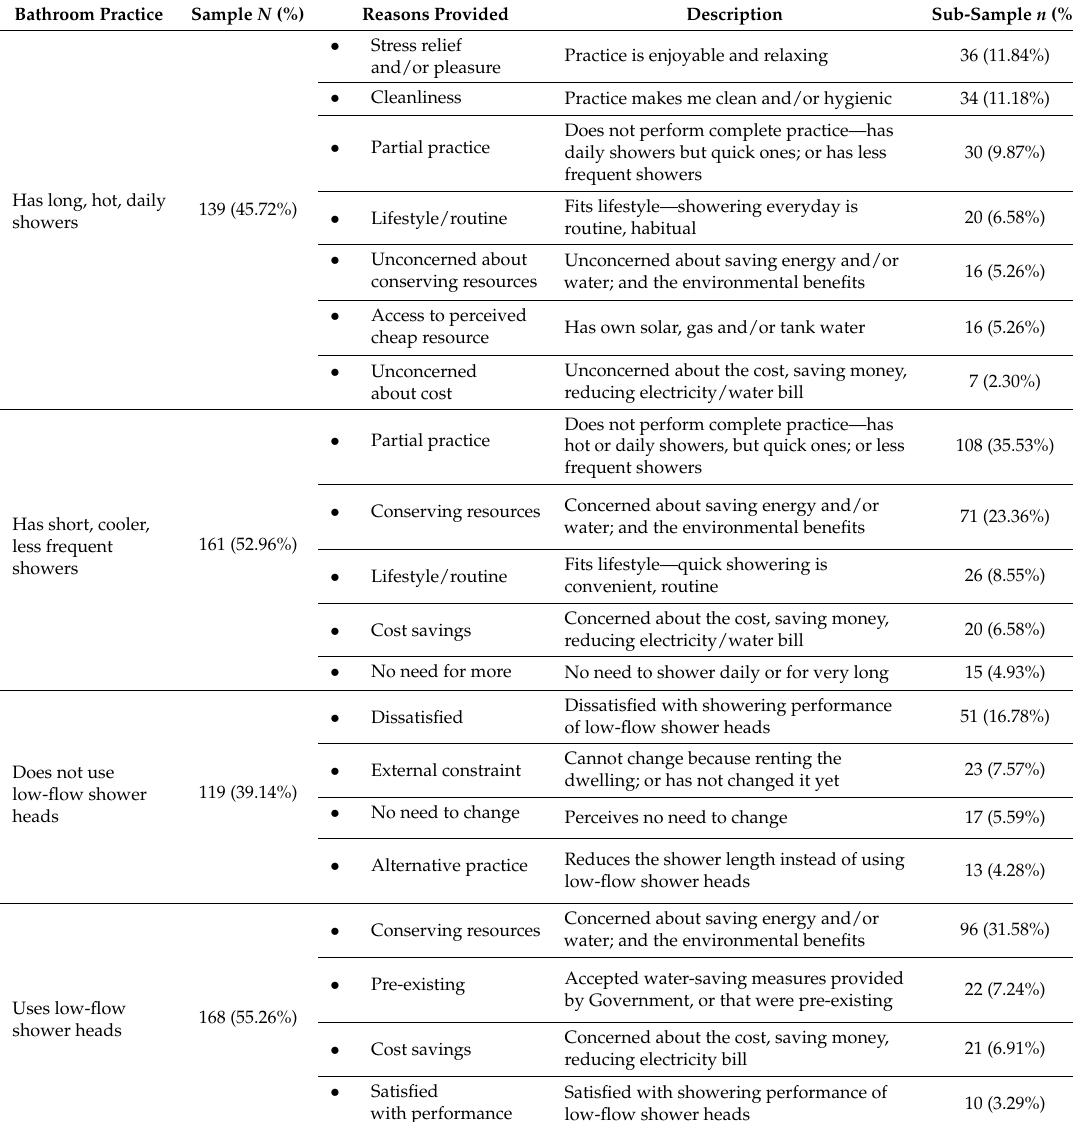
Table 3. Reasons given for engaging in energy-efficient and energy-inefficient practices in the bathroom domain ( N =